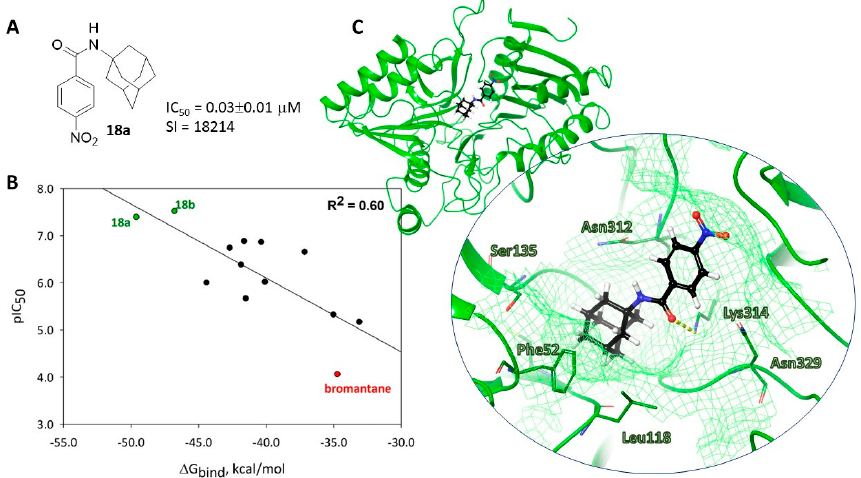
Figure 7. Molecular docking results: ( A )—lead-compound; ( B )—correlation between experimental and molecular docking data; ( C )—location lead-compound in binding site. and molecular docking data; ( C )—location lead-compound in binding